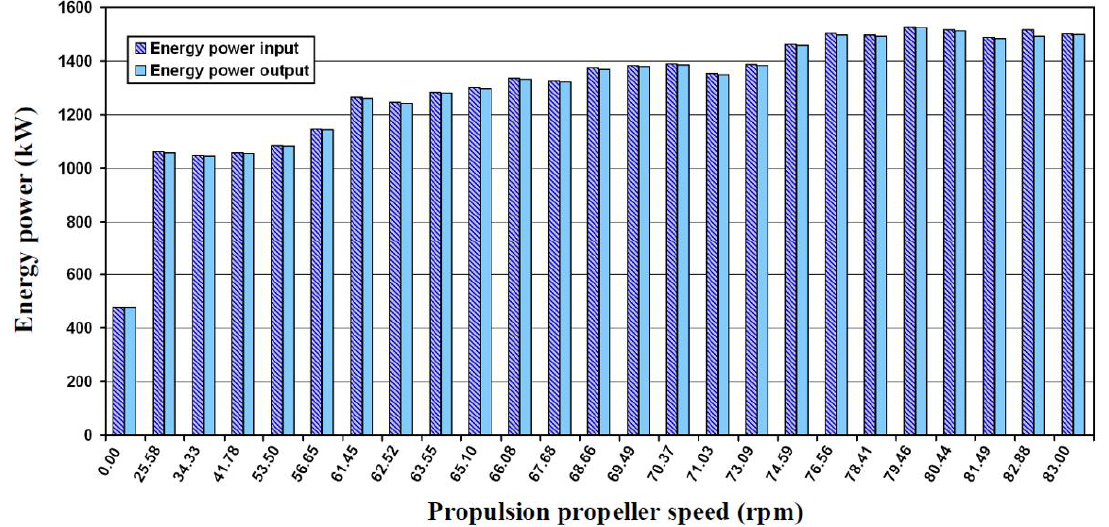
Figure 5. Steam air heater energy power input and output for various loads.